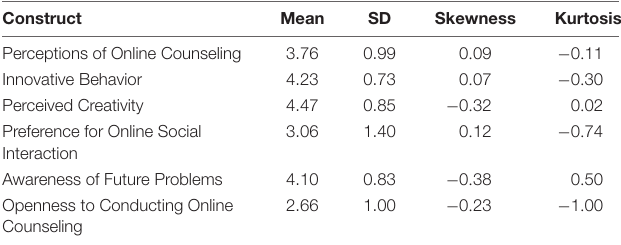
TABLE 1 | Descriptive statistics of the research